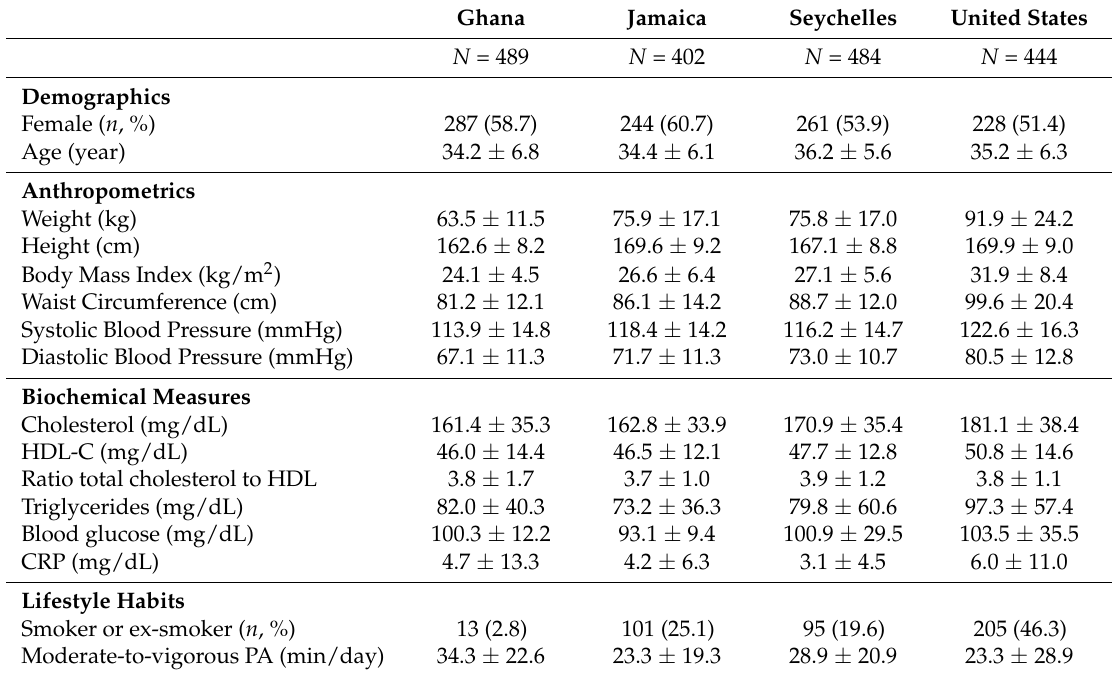
Table 1. Descriptive characteristics of study population by site.